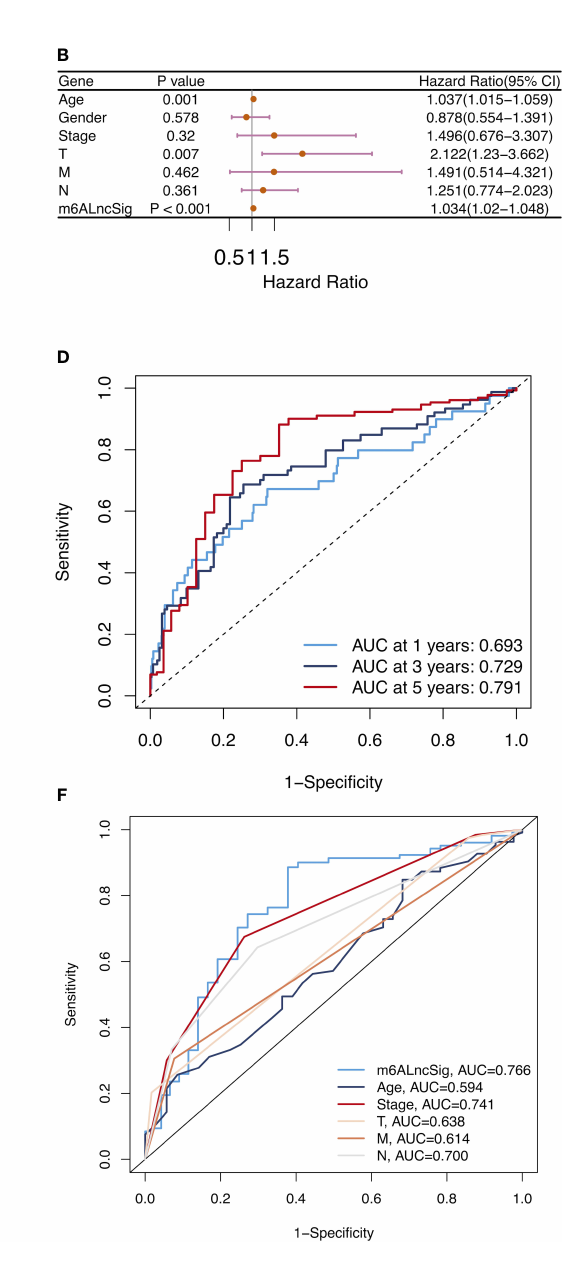
FIGURE 10 Assessment of m6ALncSig and clinicopathological features in the TCGA training and entire sets. (A, B) Univariate and multivariate Cox regression analysis of clinicopathological features and risk score. (C, D) ROC curves of the training and entire sets at 1, 3, and 5 years. (E, F) ROC curves for the clinical characteristics and risk score in the training and entire